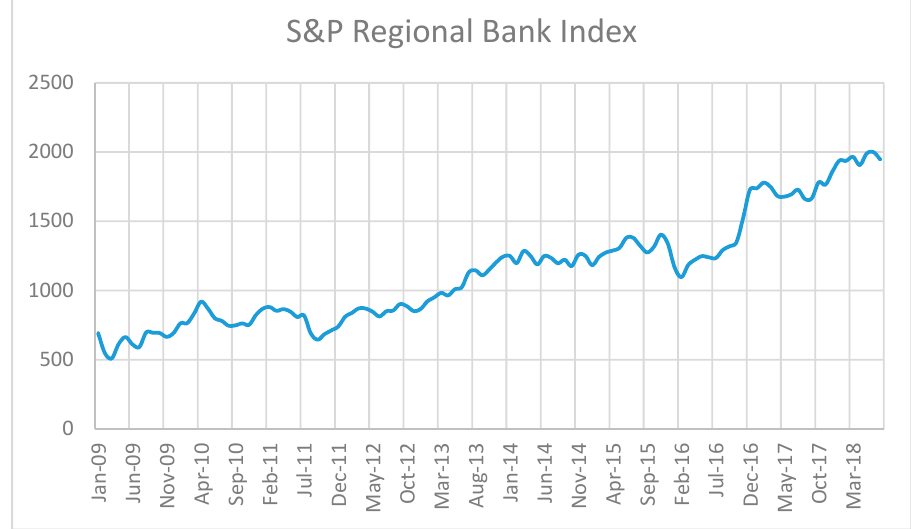
Figure 1. S&P Regional Bank Index. Source: Standard and Poor’s.